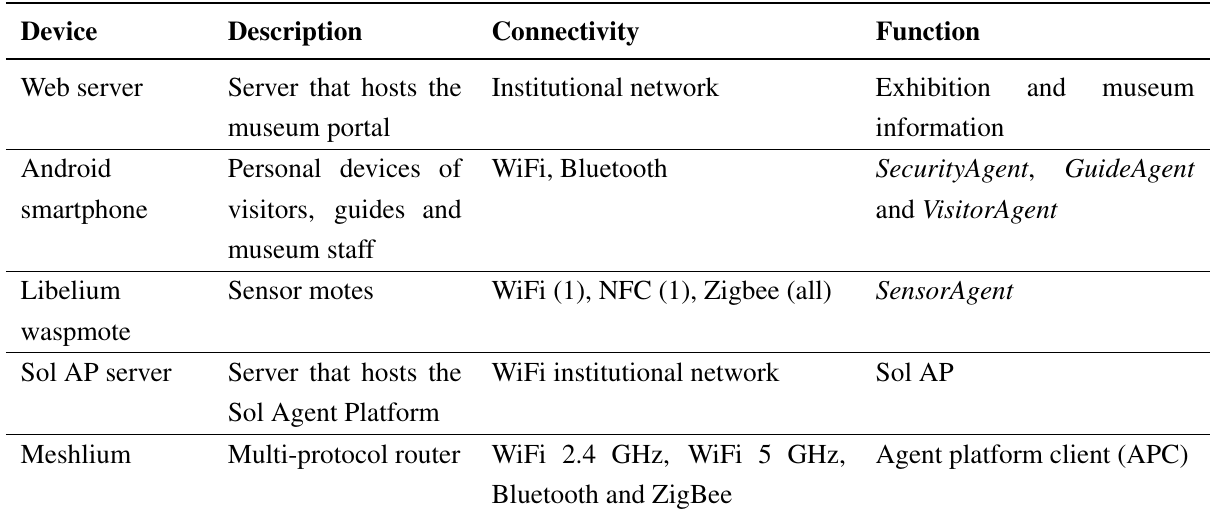
Table 1. Features of the devices of the intelligent